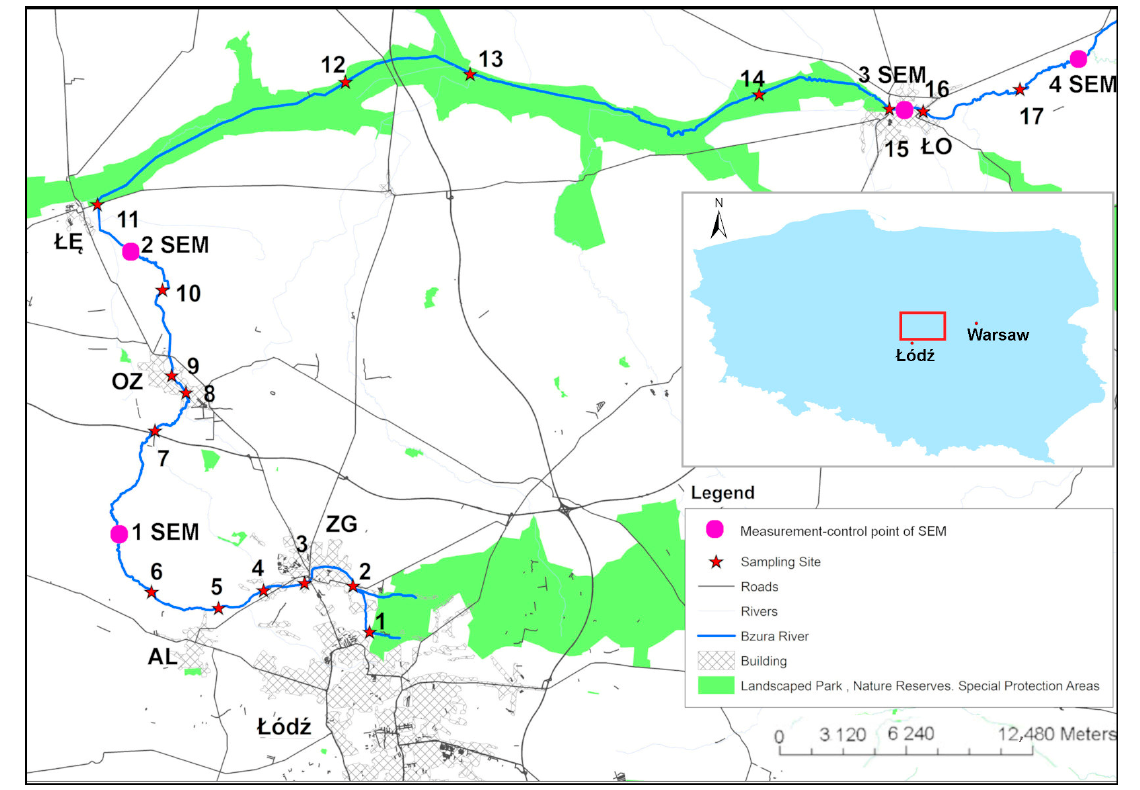
Figure 1. Sampling sites and measurement control points of the SEM location.